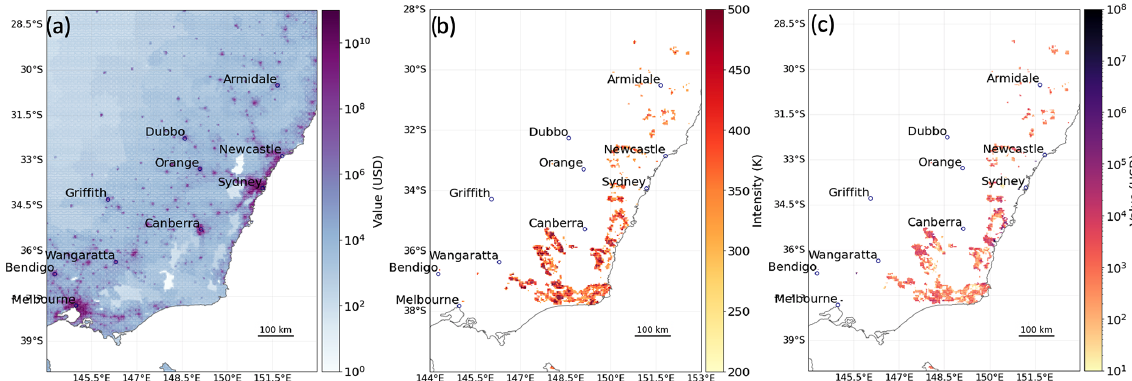
Figure 2. Maps of south-eastern Australia showing (a) the spatial distribution of asset exposure value generated using LitPop, (b) the wildfires active between 29 December 2019 and 6 January 2020, and (c) the resulting damage per grid point as estimated by CLIMADA. The largest impacts stem from the comparably small fires close to Melbourne and